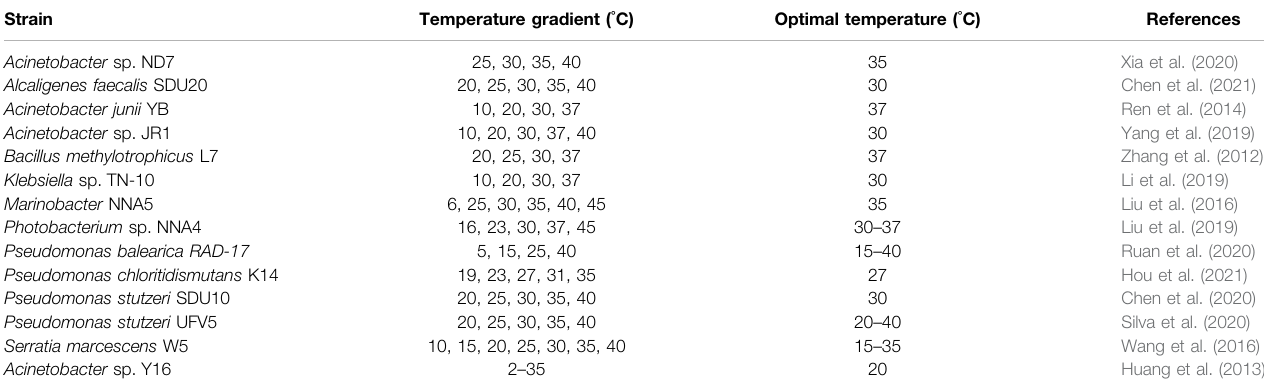
TABLE 7 | Ranges of temperature for HNADs. Strain